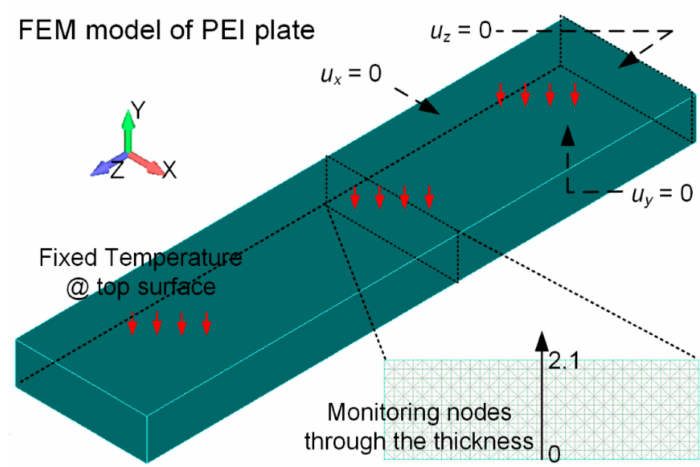
Figure 2. Finite element model of the PEI plate.